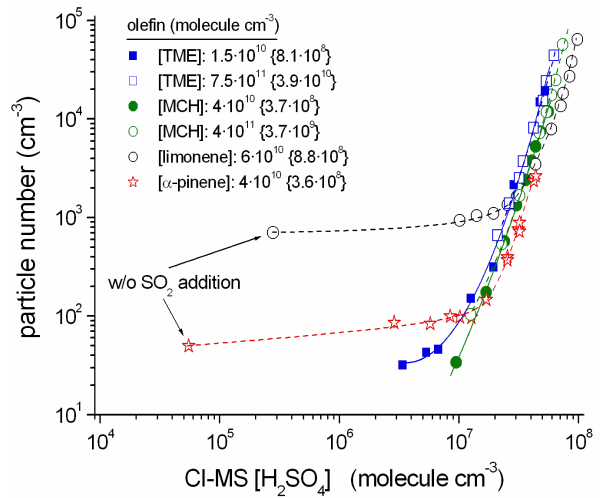
Fig. 2. Raw particle numbers from PHA-UCPC measurements in dependence on measured H 2 SO 4 concentration by variation of SO 2 for constant ozonolysis conditions. Initial olefin concentrations are given along with the converted olefin by ozone (in brackets), mea- surement series 3, 4, 6, 7, 11 and 15. The data for very low H 2 SO 4 concentrations (<10 6 moleculecm − 3 ) were obtained without SO 2